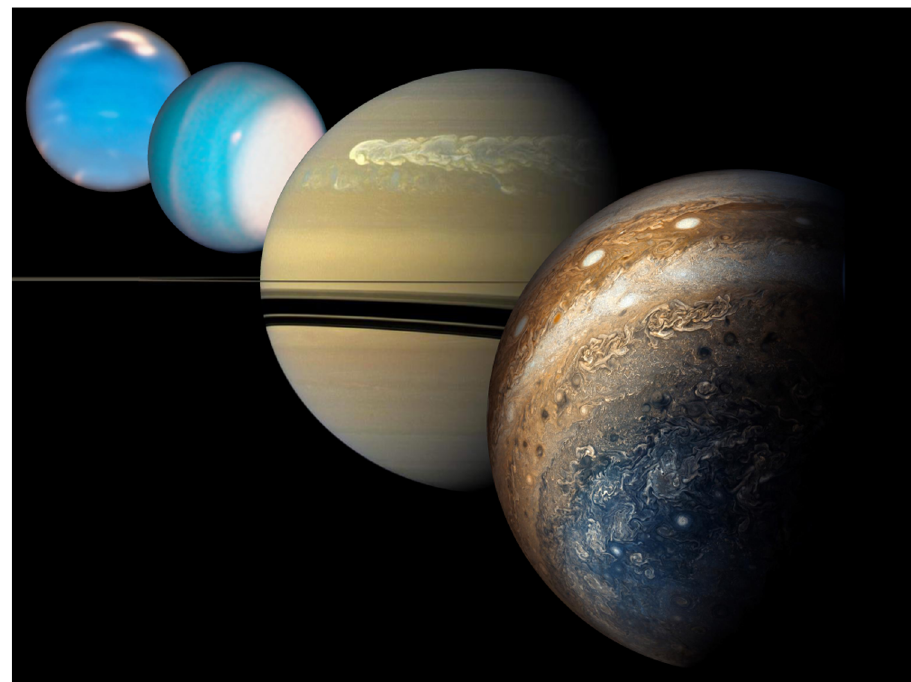
Fig. 1 The four giant planets shown to scale. From closest to furthest (or right to left) respectively: Jupiter (Juno perijove 6, Credit:NASA/SwRI/MSSS/ Gerald Eichstädt/Seán Doran); Saturn during the great storm of 2010 – 2011 (Cassini, Credit: NASA/JPL-Caltech/Space Science Institute); Uranus and Neptune (Hubble, Credits: NASA/ESA/A. Simon (NASA Goddard Space Flight Center), and M.H. Wong and A. Hsu (University of California,